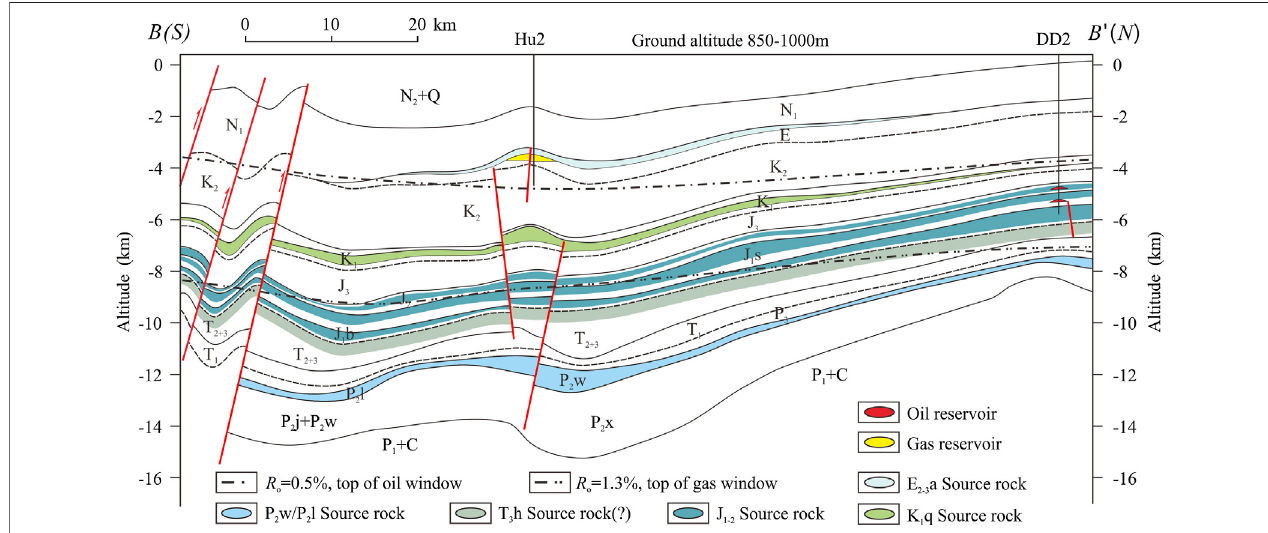
FIGURE 8 | Sketch diagram of structure, source rock burial evolution and hydrocarbon migration and accumulation section in the middle of southern margin.